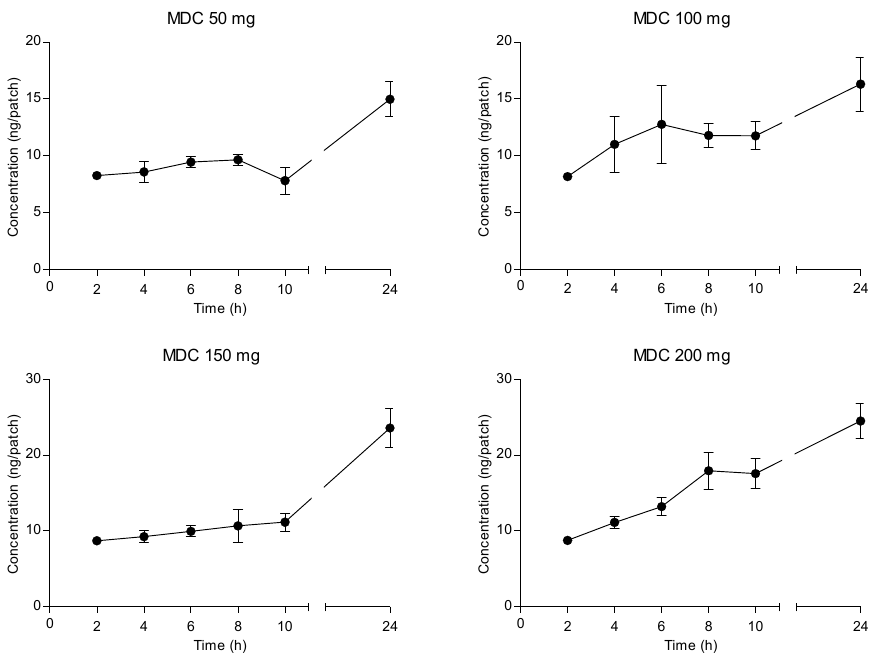
Figure 2. Concentration–time profile of metabolite MDC contained in sweat patches following increased controlled methylone administrations (50, 100, 150 and 200 mg).